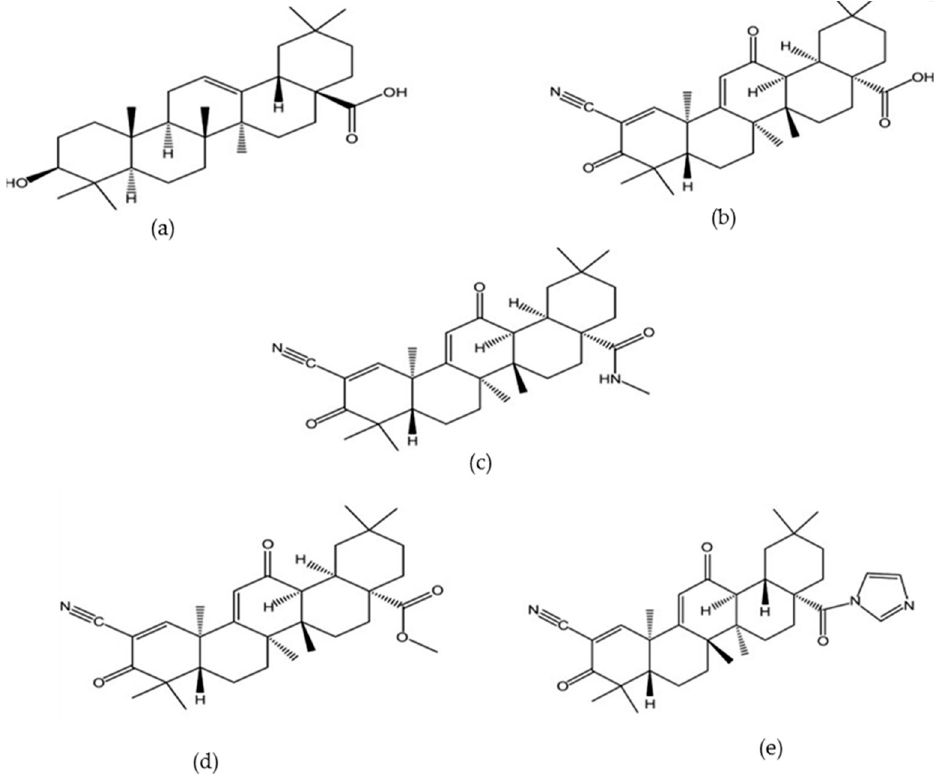
Figure 1. Structures of oleanolic acid and some of its derivatives ( a ) Oleanolic acid ] ( b ) CDDO ( c ) CDDO-Ma ] ( d ) CDDO-Me ( e ) CDDO-Im [17] .